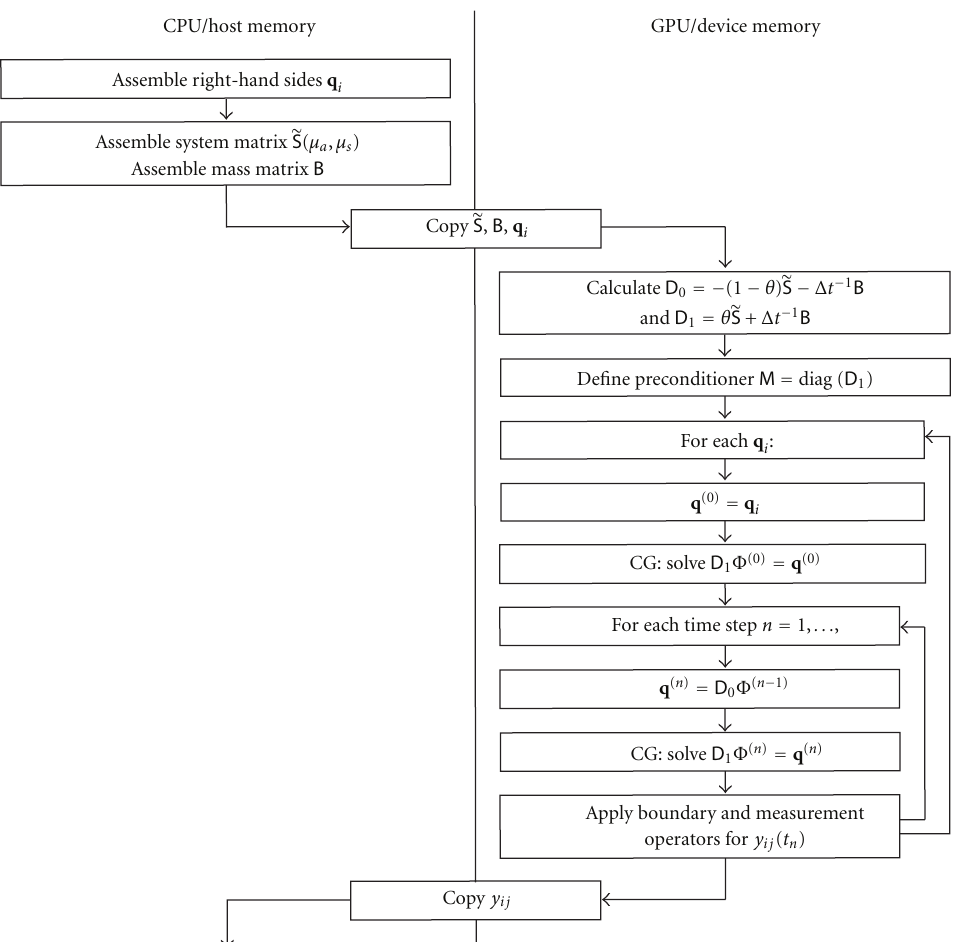
Figure 2: Data flow between host and graphics device for solution of linear problem